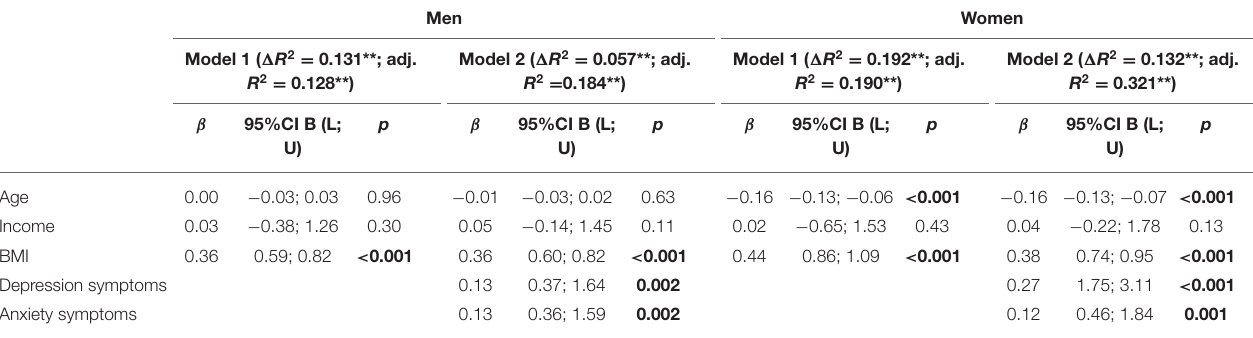
TABLE 3 | Hierarchical linear regression of eating disorder symptoms (dependent variable: EDE-Q8 sum score), stratified by gender. Men